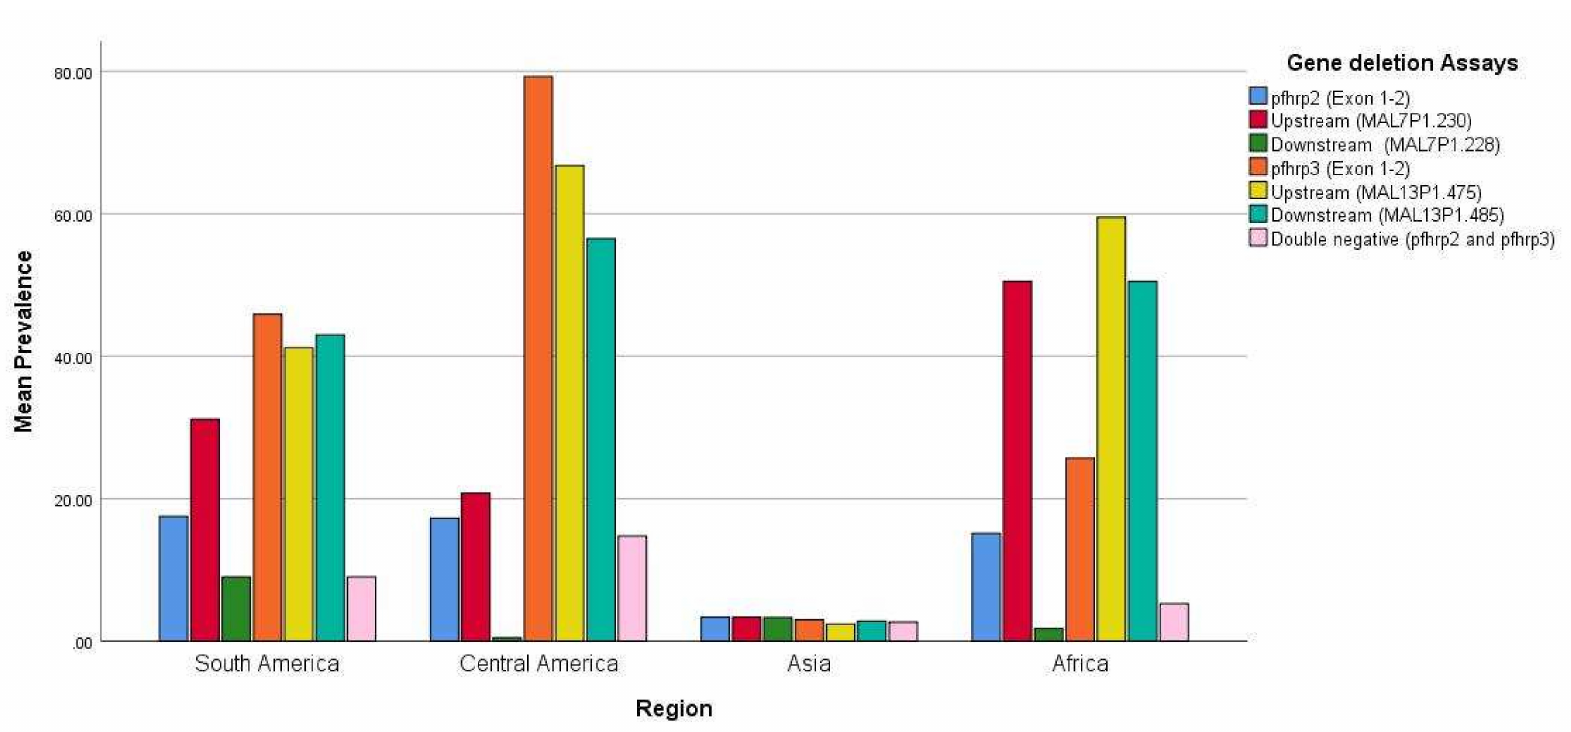
Figure 3. Bar chart showing the mean prevalence and distribution of pfhrp2, pfhrp3 , and the corresponding flanking gene deletions in South America, Central America, Asia, and